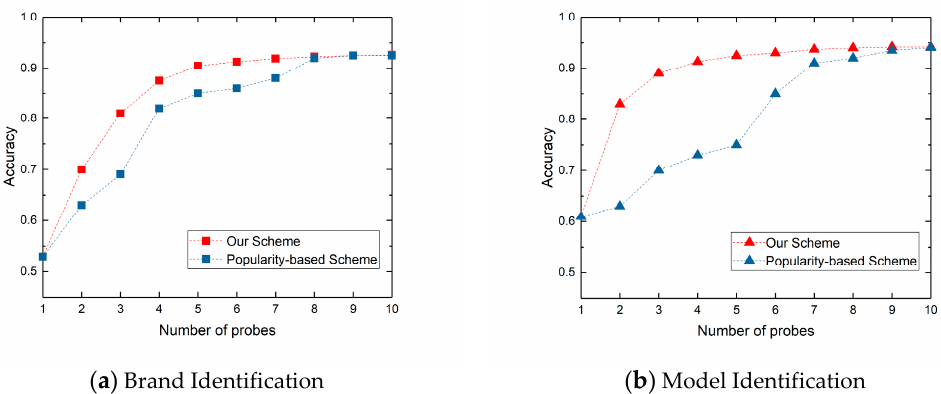
Figure 9. The comparison of identification accuracy between our schemes with others.